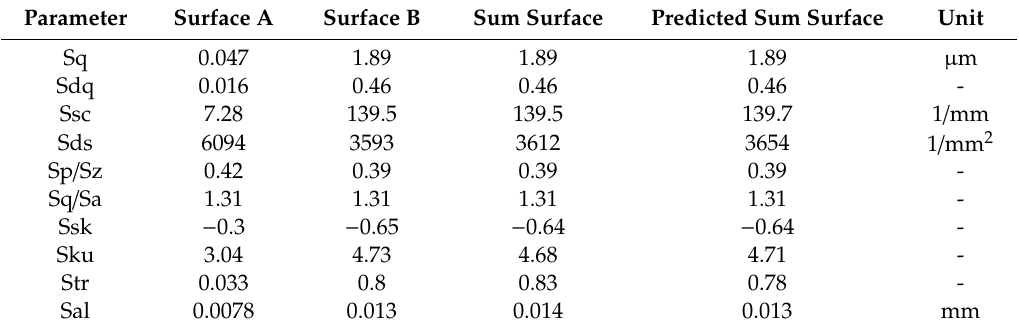
Table 3. Selected parameters of surface A, of surface B, of the sum surface, and of predicted parameters of the sum surface.